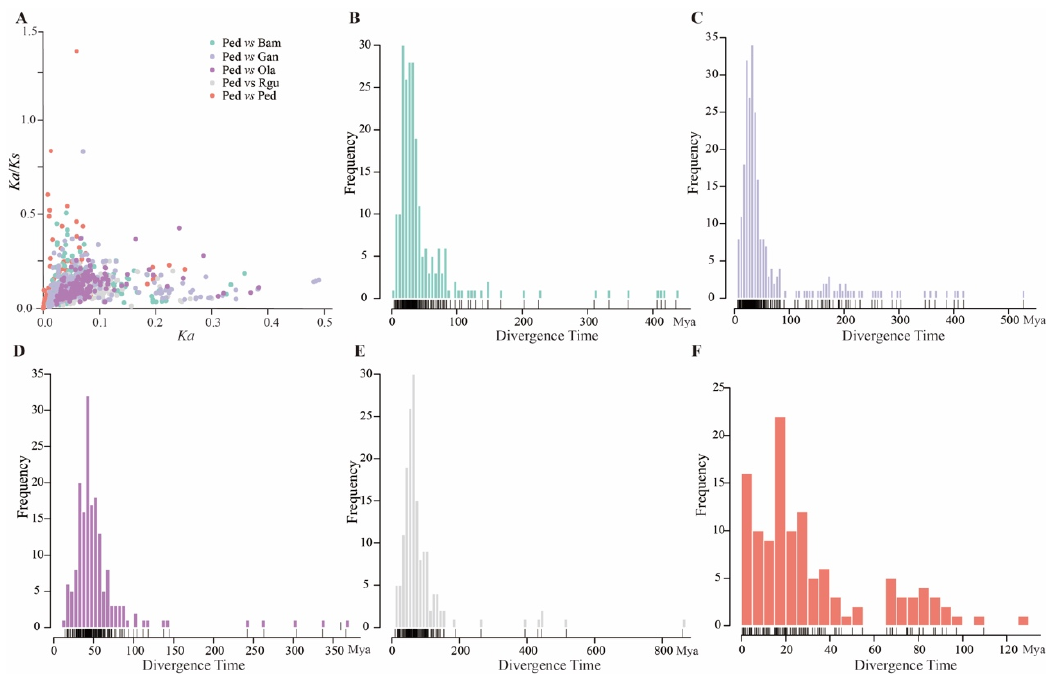
Figure 5. Evolutionary analyses of paralogous peroxidase gene pairs of P. edulis and orthologous peroxidase gene pairs between P. edulis (Ped) and the other four bamboo species of B. amplexicaulis (Bam), G. angustifolia (Gan), O. latifolia (Ola), and R. guianensis (Rgu). ( A ) The Ka / Ks values of paralogous peroxidase gene pairs in P. edulis and orthologous peroxidase gene pairs between P. edulis and the other four bamboo species. ( B ) The divergence time of orthologous peroxidase gene pairs between P. edulis and B. amplexicaulis . ( C ) The divergence time of orthologous peroxidase gene pairs between P. edulis and G. angustifolia . ( D ) The divergence time of orthologous peroxidase gene pairs between P. edulis and O. latifolia . ( E ) The divergence time of orthologous peroxidase gene pairs between P. edulis and R. guianensis . ( F ) The divergence time of paralogous peroxidase gene pairs in P. edulis .